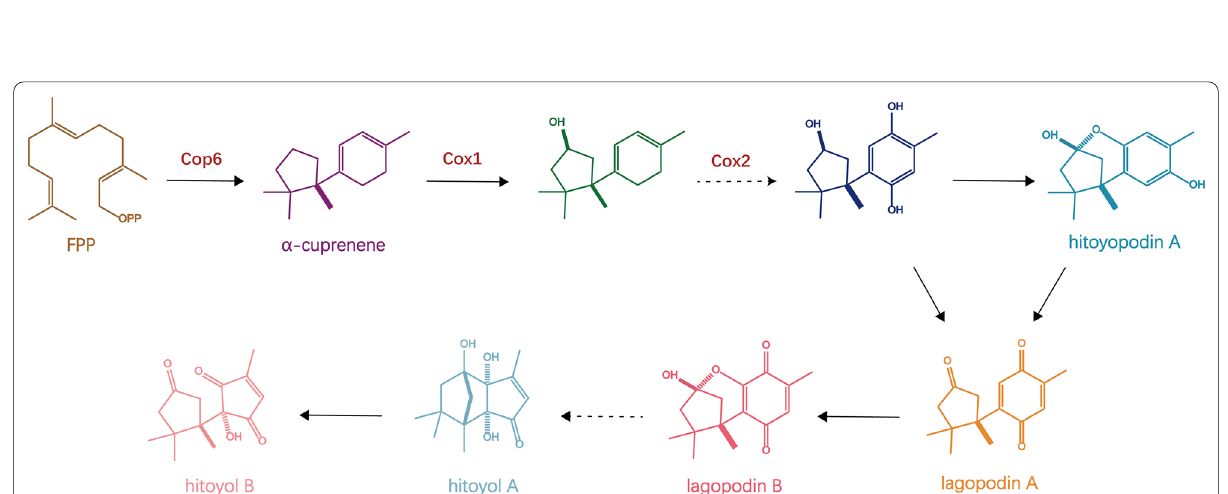
Fig. 4 The speculated biosynthetic pathways of lagopodins and hitoyols synthesized through copperene and other